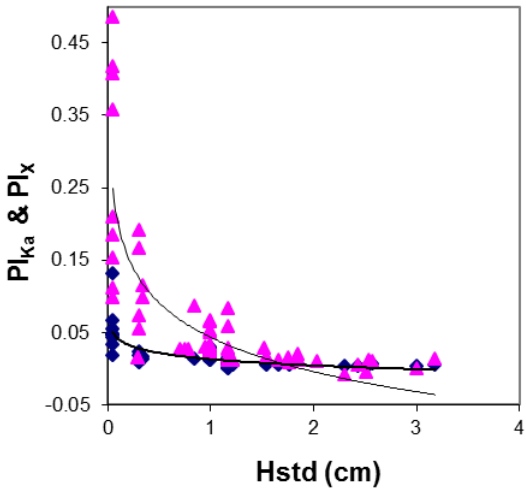
Figure 6. PI, at X (triangles) and Ka (rhombs) bands, vs. Hstd